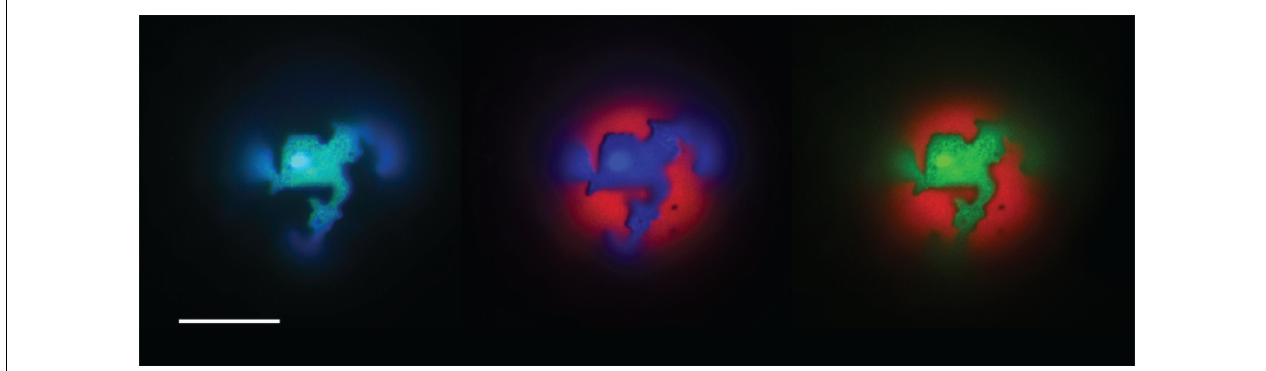
FIGURE 1 |The partitioning behavior of three amphiphilic dyes in a DOPC:DPPC (1:1) GUV entrapping 1M sucrose. Left blue channel (Laurdan) and green cannel (488-DPPE) – both staining the S o phase. Center red